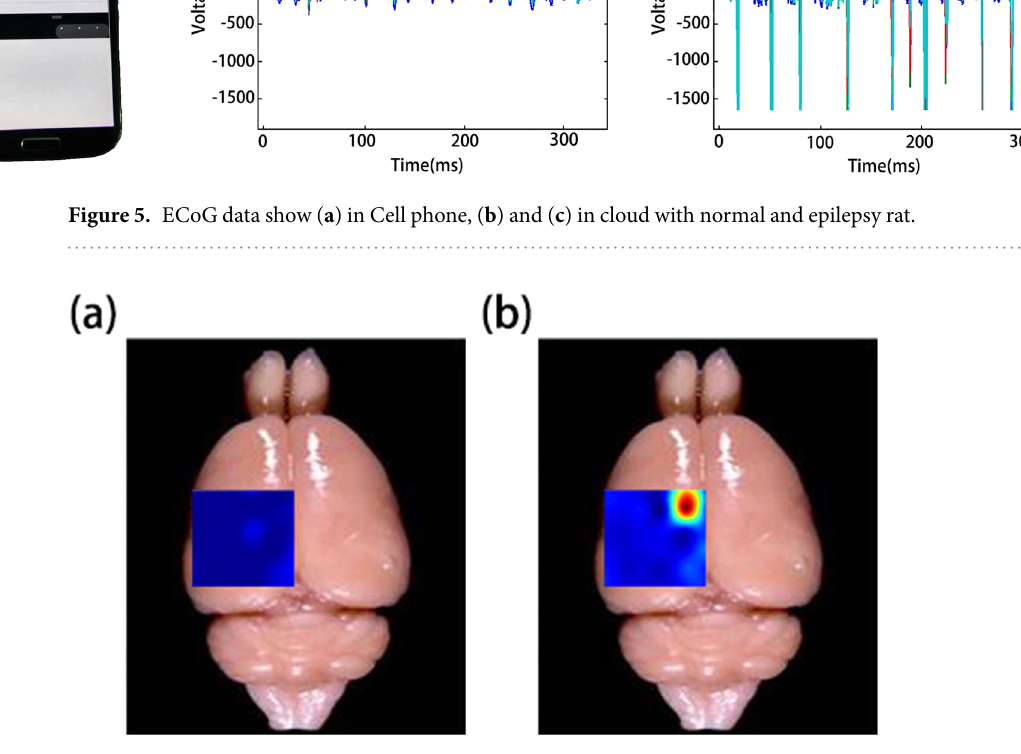
Figure 6. Mapping of ECoG signal amplitudes on the rat brain. Mappings of ECoG signal amplitudes from a rat brain under normal state ( a ) and epilepsy state ( b ). The red area has the highest amplitude, i.e. most active under epilepsy, which allows us to identify the epilepsy lesions in the brain.